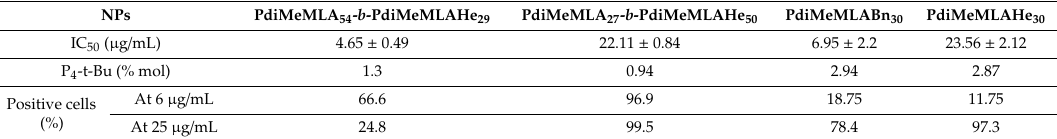
Table 8. Comparison of the IC 50 of the homopolymer- and amphiphilic block copolymer-based NPs in progenitor HepaRG cells, the estimated percentage of P 4 -t-Bu (% mol) found in 1 H-NMR spectra of (co)polymers and the percentages of cells that internalized fluorescent NPs (% of positive cells) quantified by flow cytometry in cultures exposed with 6 and 25 µ g / mL of (co)polymers. NPs PdiMeMLA 54 - b -PdiMeMLAHe 29